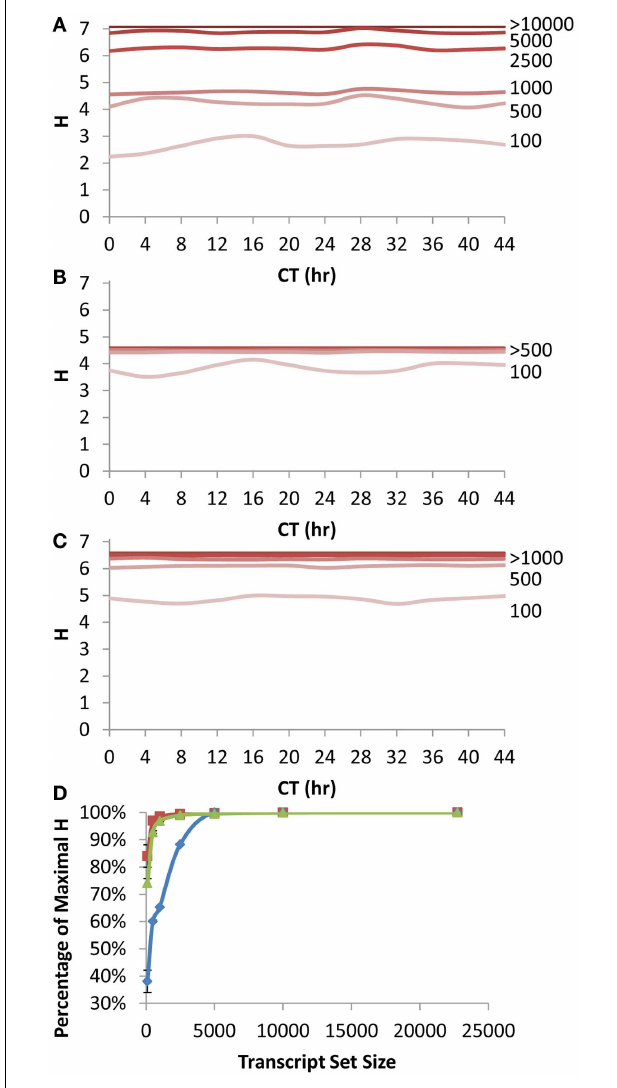
FIGURE 4 | Shannon Entropy estimation of information in circadian time course experiment. A previous microarray analysis of a 44h circadian time course with the Affymetrix ATH1 microarray was obtained to analyze the Shannon Entropy within the analysis.The genes were independently ranked in each time point and the Shannon entropy for the different gene sets analyzed for each time point. (A) The estimated Shannon entropy across the different time points (CT hour) using the scale free transcript network.Transcript set sizes are as labeled.The lines for 10,000 and 22,746 transcripts are indistinguishable and labeled > 10,000. (B) The estimated Shannon entropy across the different time points using the 1h CT group network assignment from the same data.Transcript set sizes are as labeled.The lines for 500, 1000, 2500, 5000, 10,000, and 22,746 transcripts are indistinguishable and labeled > 500. (C) The estimated Shannon entropy across the different time points using the 1/4h CT group network assignment from the same data.Transcript set sizes are as labeled.The lines for 1000, 2500, 5000, 10,000, and 22,746 transcripts are indistinguishable and labeled > 1000. (D) The average fraction of maximal Shannon entropy per gene set size across all time points. Diamonds show the scale free network, squares show the 1h CT group network while triangles are the 1/4h CT group networks. Standard deviation is shown. If bars are not visible then the standard deviation is smaller than the symbol for that